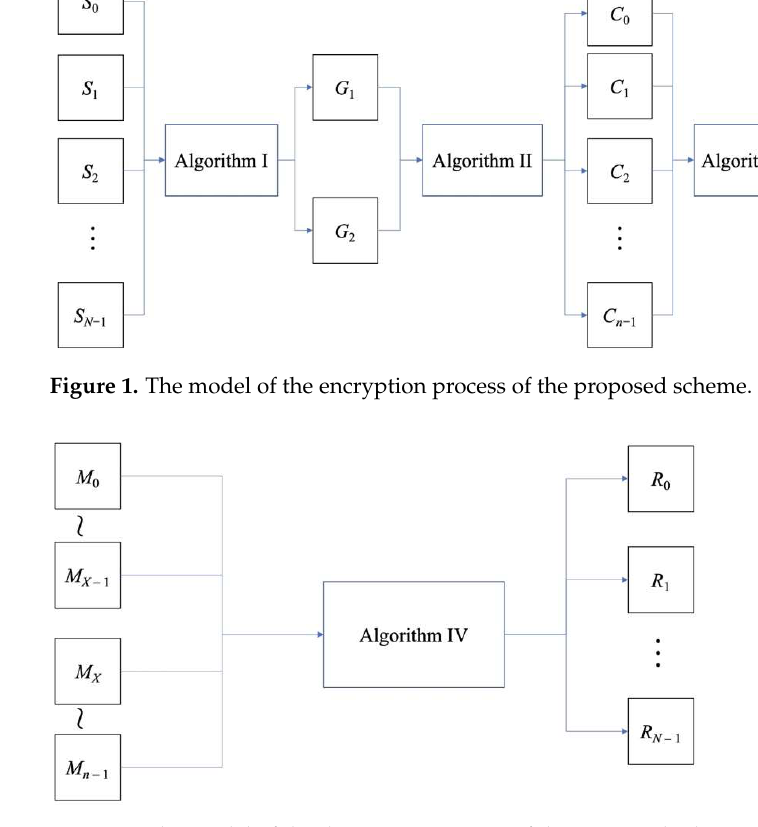
Figure 2. The model of the decryption process of the proposed scheme.